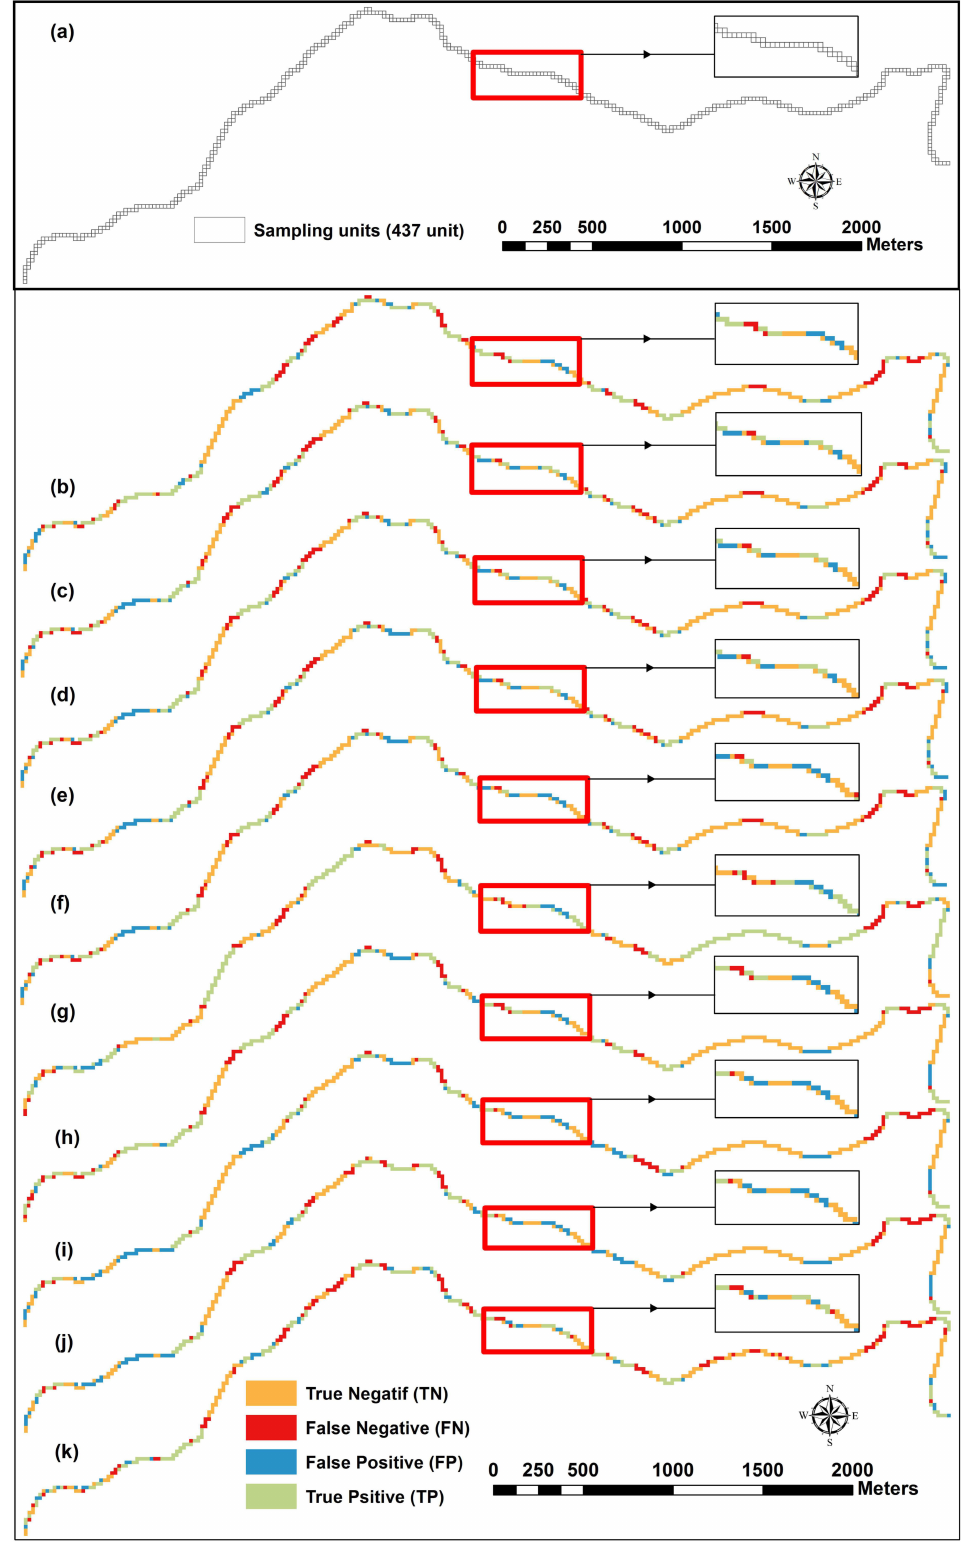
Figure 6. Sampling units (10 × 10 m) for the control and test groups in the study area ( a ). Spatial data accuracy without generalization tolerance ( b ), Douglas-Peucker generalization tolerance values: 20 cm ( c ), 40 cm ( d ), 60 cm ( e ), 80 cm ( f ), 1 m ( g ), 2 m ( h ), 3 m ( i ), 4 m ( j ) and the map displaying true/false distributions for the forest road with Bezier generalization algorithm ( k